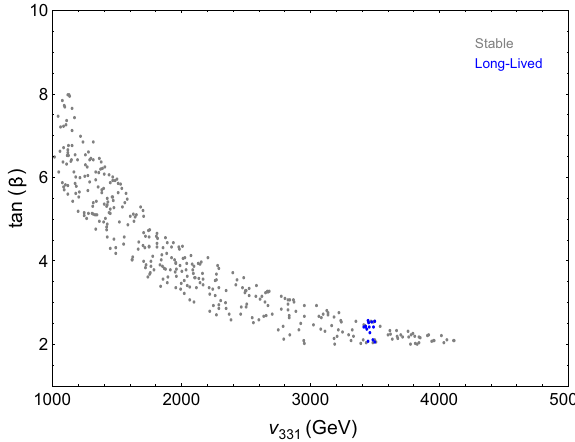
Fig. 7 Points in the plane tan (β) versus v 331 that guarantee stability of the